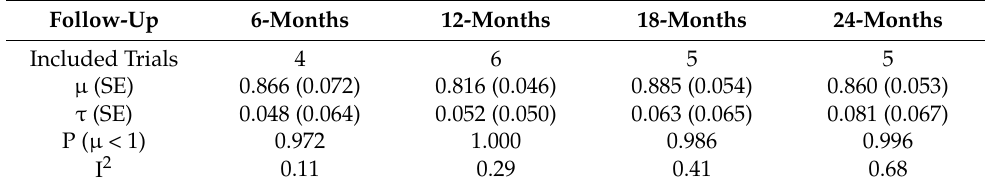
Figure 4. Funnel plots for the secondary variable—the scaled progression of axial length (AL) at the 12-months and 24-months follow-ups with all trials included ( a , b , respectively). Table 5. The number of included trials, the estimated values of µ , τ and their associated standard errors, the probability that µ is less than 1, and the values of relative heterogeneity for the secondary variable (scaled axial length) at different time intervals with all the trials